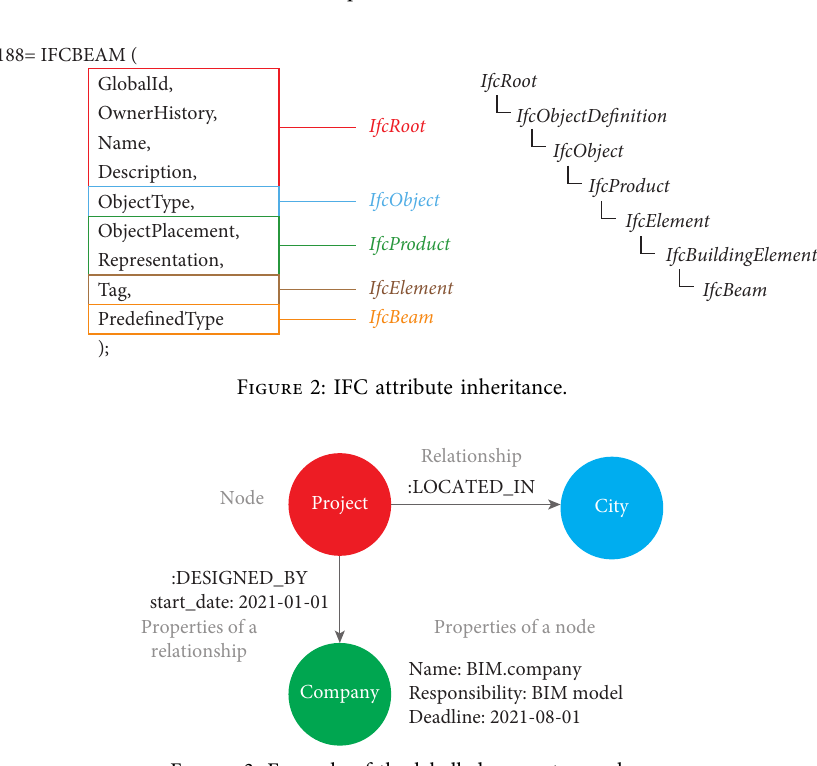
Figure 1: EXPRESS specification for the IfcBeam class.